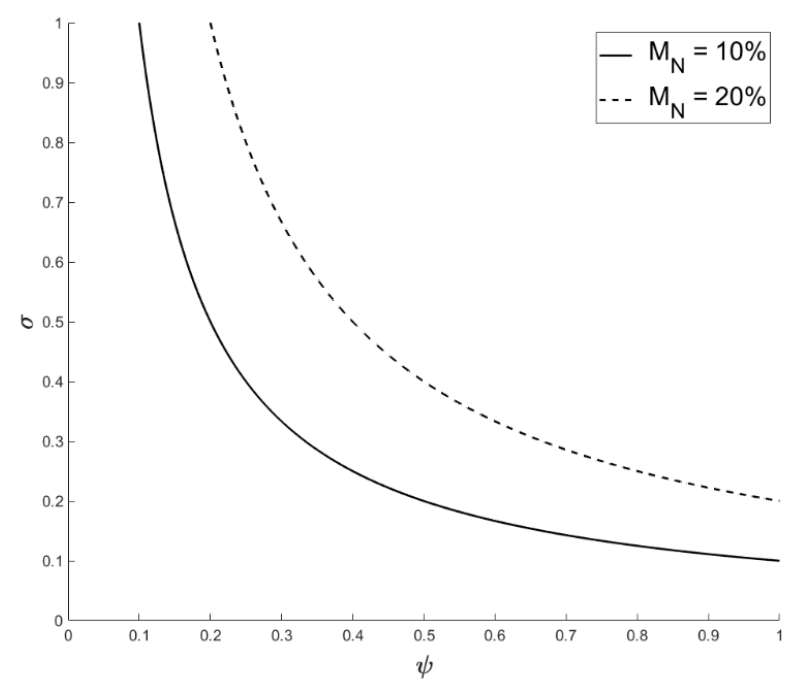
Figure 2. The interaction between σ and Ψ , under which R o ≥ 1, when A S = 99 and an M N = 20% (upper dashed-curve) and when the initial conditions of A S = 49 and an M N = 10% (lower curve), where Ψ is the contact rate and σ is the likelihood of transmission for the model.